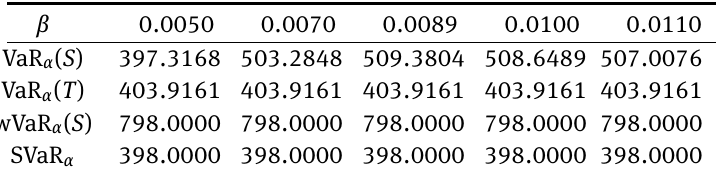
Table 3: Summarized results for Example